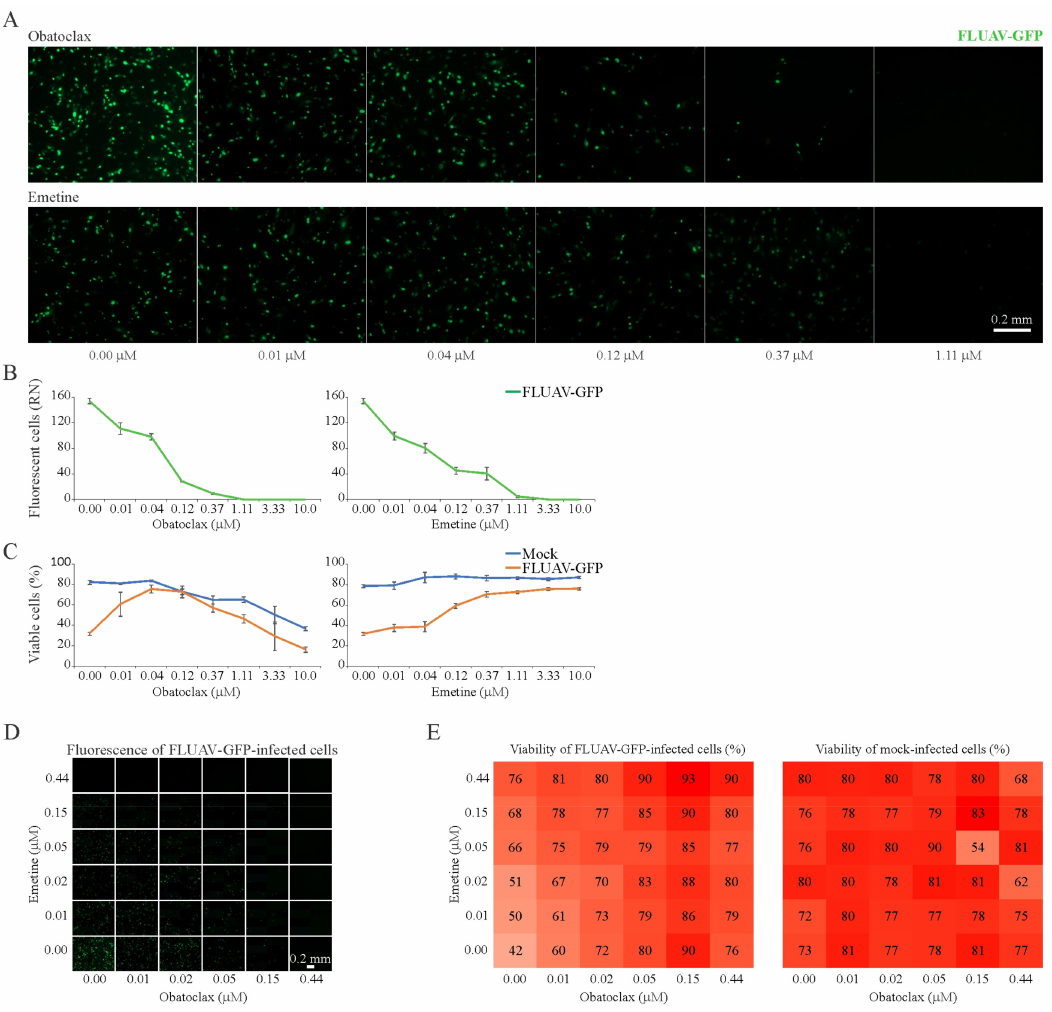
Figure 7. E ff ect of obatoclax, emetine and their combinations on influenza A virus (FLUAV)-mediated GFP expression and the viability of mock- and virus-infected RPE cells. ( A , B ) RPE cells were treated with increasing concentrations of a compound and infected with FLUAV-GFP (moi, 0.5). After 24 h, the cells were imaged and fluorescence intensity was quantified (Mean ± SD; n = 3). ( C ) Cell viability was determined with the CTG assay (Mean ± SD; n = 3). ( D – E ) The interaction landscapes of the emetine-obatoclax drug combination on FLUAV-mediated GFP expression and the viability of FLUAV- and mock-infected RPE cells, as measured with CTG